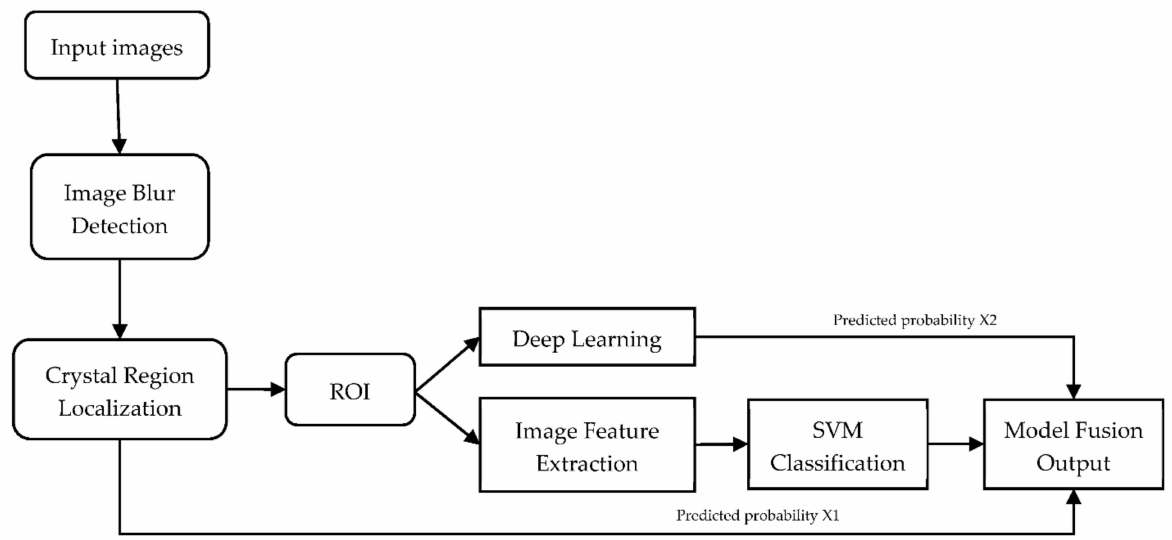
Figure 3. Unified framework for automated nuclear cataract severity classification